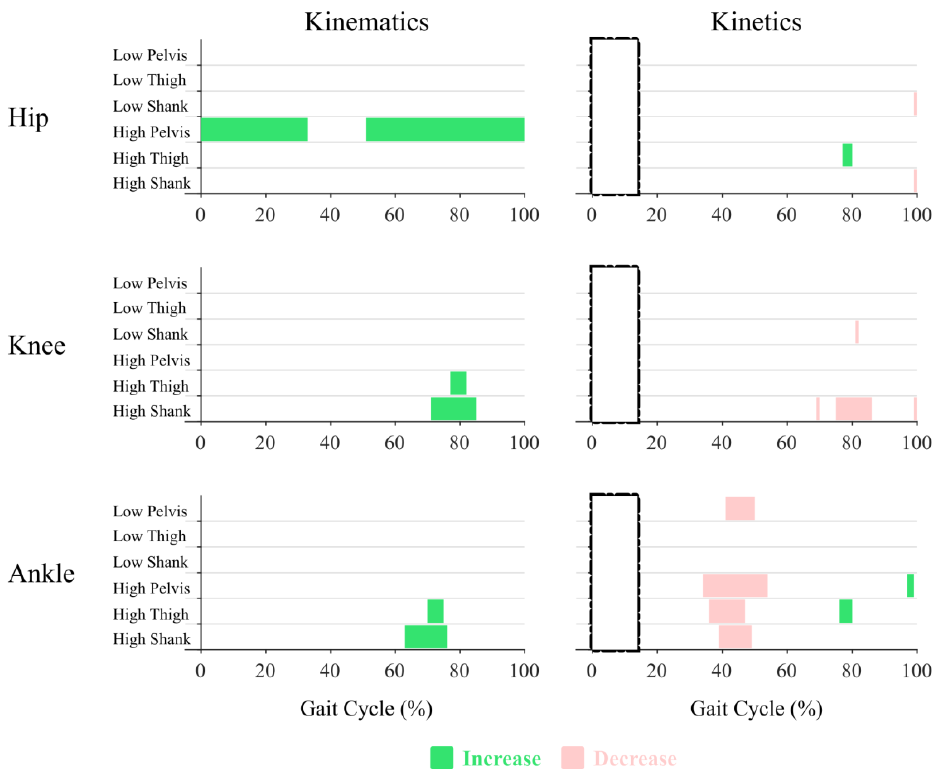
Figure 2. Joint kinematics and kinetics SPM significance highlighted in color over the gait cycle. Significance is achieved when SPM{t} exceeds its critical value. Comparisons are all with respect to the Baseline condition. Rectangles with dash-dotted edges are used to mask the early stance joint kinetics for lack of necessary ground reaction force data.